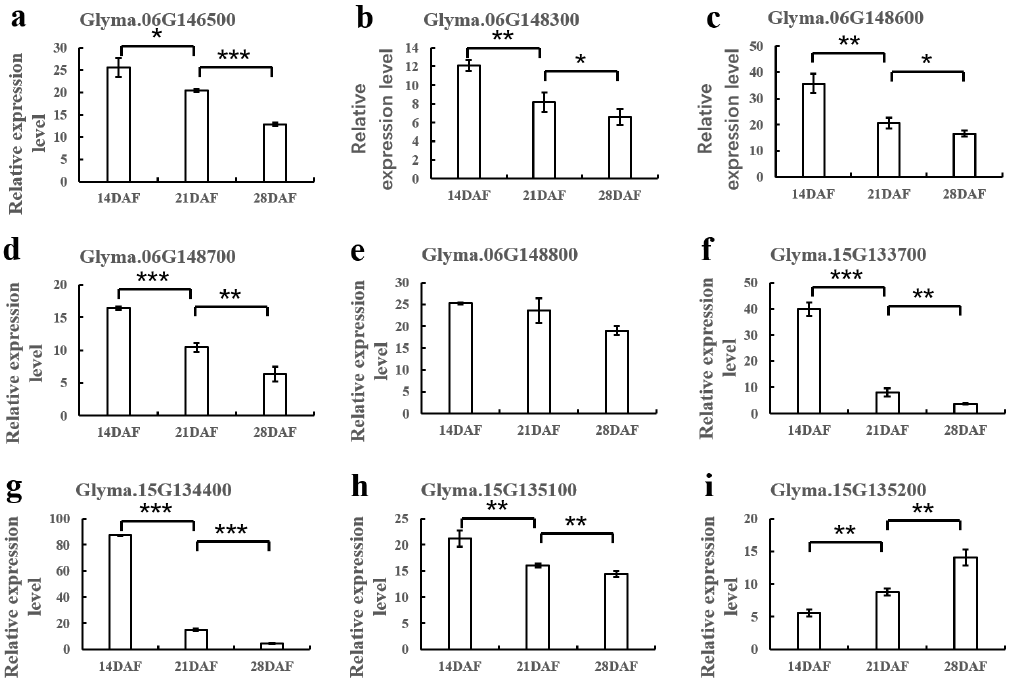
Figure 6. The expression of candidate genes at 14, 21, and 28 DAF. ( a – i ) The relative expression level of Glyma.06g146500, Glyma.06g148300, Glyma.06g148600, Glyma.06g148700, Glyma.06g148800, Glyma.15g133700, Glyma.15g134400, Glyma.15g135100, and Glyma.15g135200 in 14, 21, and 28 DAF. DAF, days after flowering. *, p < 0.05; **, p < 0.01; ***, p < 0.001. According to gene annotation in the soybean reference genome (Wm82.a2.v1), we iden- tified the homologous genes of nine candidate genes, specifically AT2G21950,